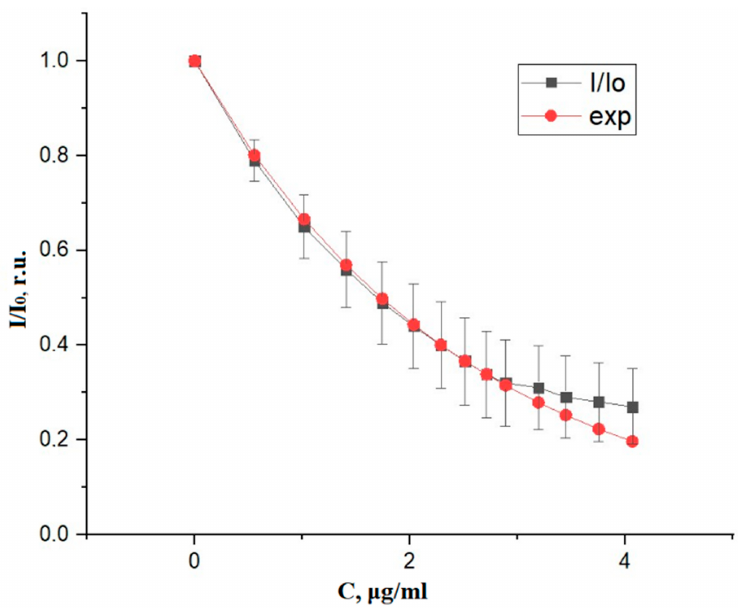
Figure 3. Ratio of intensity (I) of the light transmitted by aqueous solution of green indocyanine at low dye concentration (C) to intensity (I 0 ) of the light transmitted by water, and its approximation by an exponential function (exp).